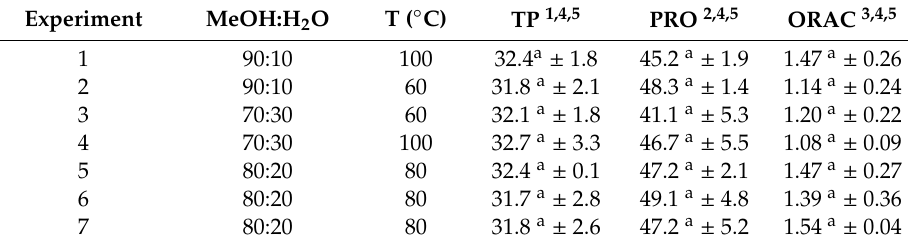
Table 2. Total Phenolics (TP), flavan-3-ols (PRO), and antioxidant activity (ORAC) determination in a commercial sample of U. tomentosa under various solvent and temperature